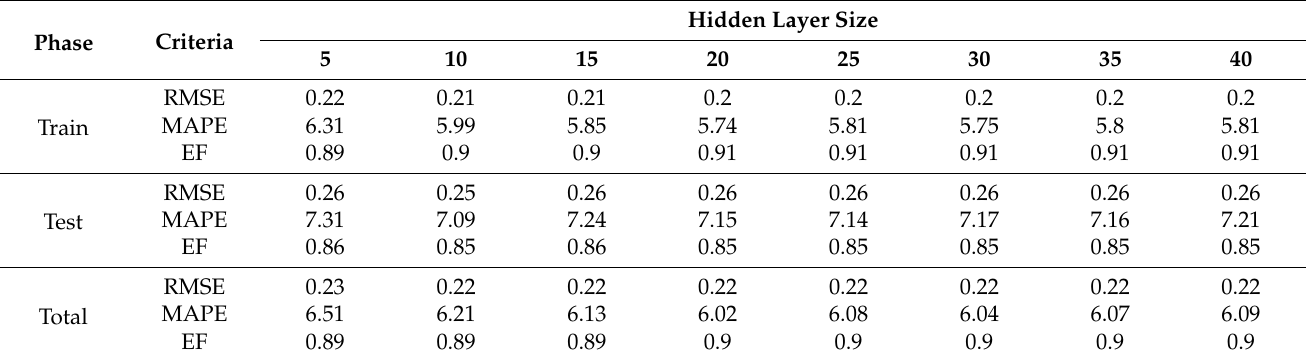
Table 7. RBF neural network performance factorial analysis with varied hidden layer neuron numbers.